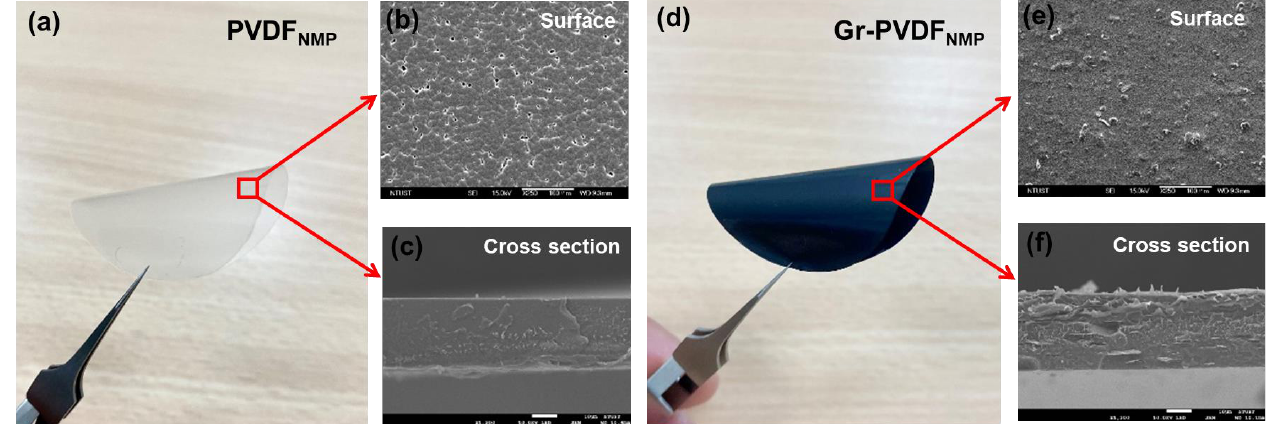
Figure 4. ( a ) Photograph of PVDF/NMP composite film. ( b ) PVDF NMP SEM surface. ( c ) The PVDF NMP SEM cross-section. ( d ) Photograph of Gr-PVDF NMP composite film. ( e ) Gr-PVDF NMP surface. ( f ) Cross-section of Gr-PVDF NMP .